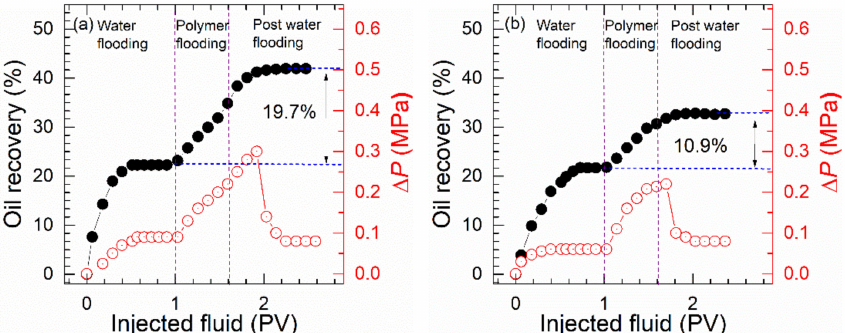
Figure 9. Oil recovery factor and flooding pressure plotted as a function of injected volume for solution of ( a ) HAP and ( b ) HPAM. (Polymer concentration, 0.175%; salinity, 3.26 × 10 5 mg/L; injection rate of 1.0